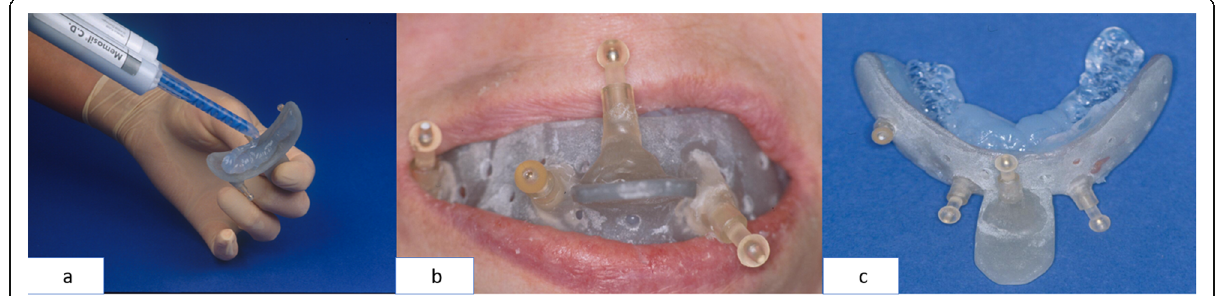
Fig. 5 Production of an oral splint for edentulous patients (vestibular splint, VestS): a vestibular pacifier with fiducial markers is filled with a- silicone, ( b ) intraoral view of VestS, ( c ) extraoral view of